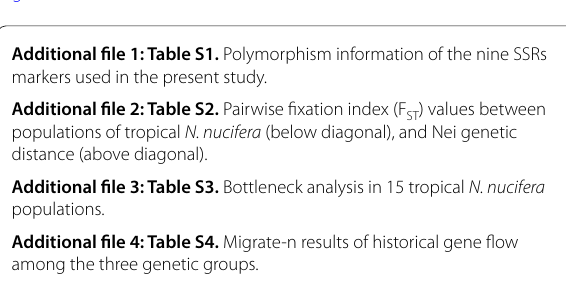
Additional file 1: Table S1. Polymorphism information of the nine SSRs markers used in the present study. Additional file 2: Table S2. Pairwise fixation index (F ST ) values between populations of tropical N. nucifera (below diagonal), and Nei genetic distance (above diagonal). Additional file 3: Table S3. Bottleneck analysis in 15 tropical N. nucifera populations. Additional file 4: Table S4. Migrate‑n results of historical gene flow among the three genetic groups. Abbreviations AMOVA: Analysis of molecular variance; H E : Expected heterozygosity; H O : Observed heterozygosity;